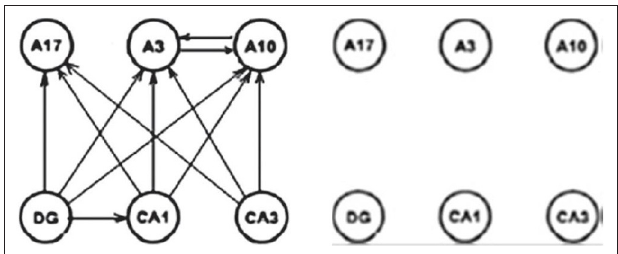
FIGURE 24 | Connectivity difference between DTF and PDC (Kasum et al.,